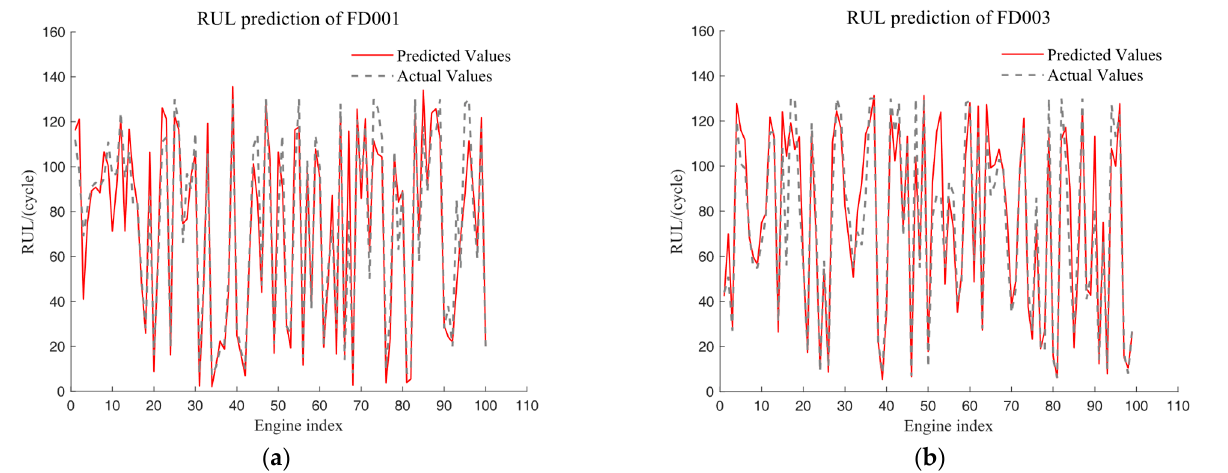
Figure 6. ( a , b ) Performance of the proposed model prediction on theFD001 and FD003 test sets.